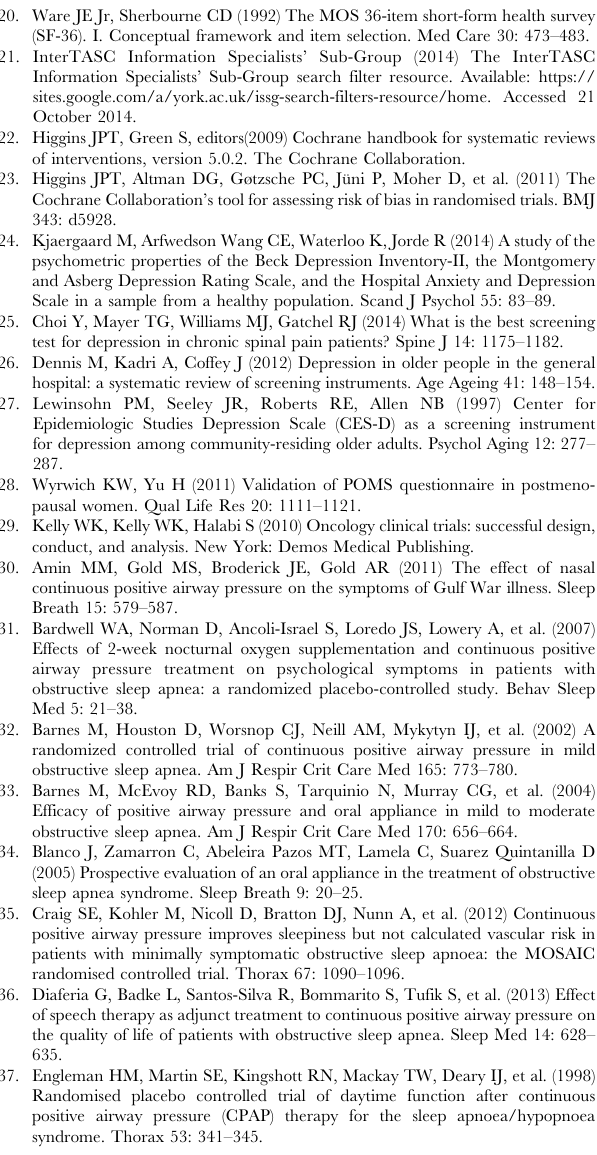
areas. Balancing of points between the left and right of the solid line indicates the absence of significant publication bias. The trials with populations that had depression at baseline have been excluded. Table S1 Medline search strategy. Detailed search terms and filters applied to generate our search. Analogous terms were used for each respective